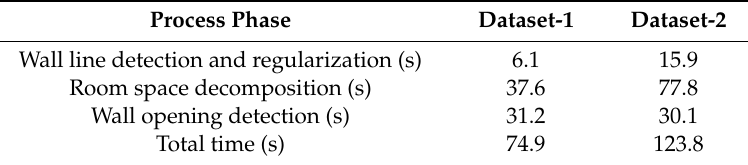
Table 3. The time consumption for each modeling phase.